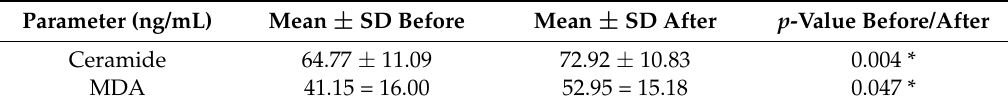
Table 4. Mean ceramide levels before and after treatment.